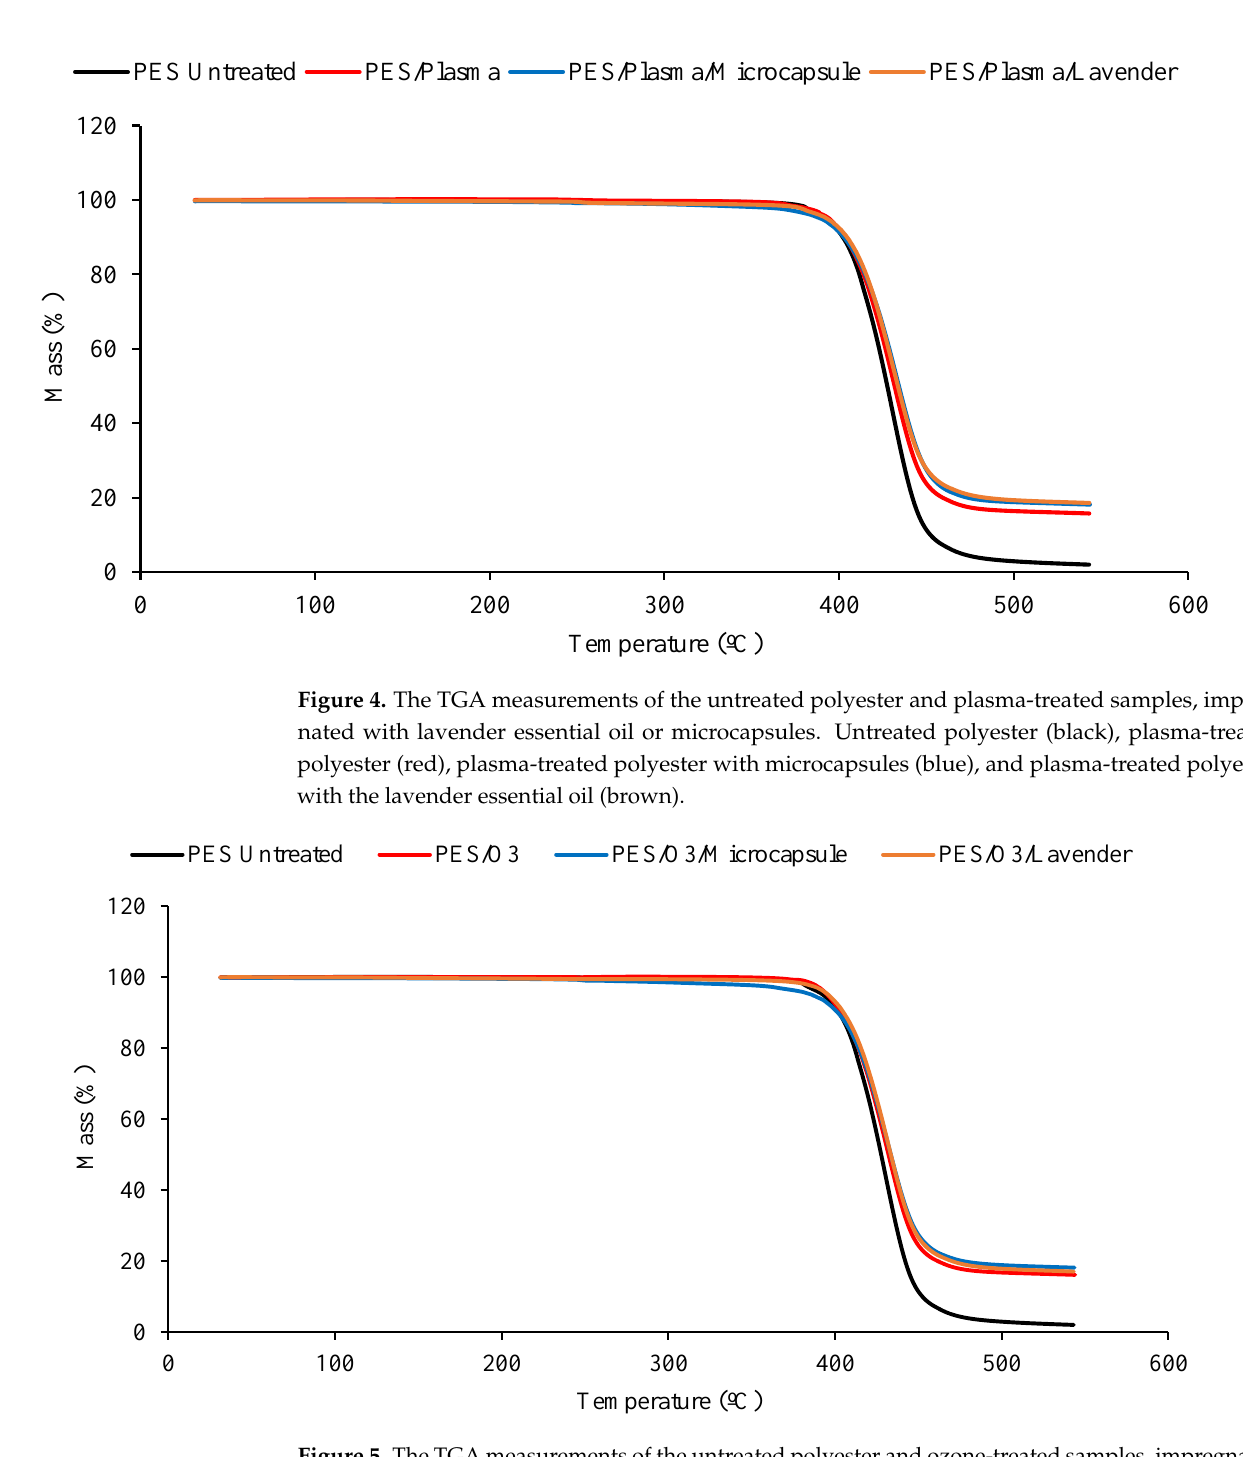
Figure 5. The TGA measurements of the untreated polyester and ozone-treated samples, impregnated with lavender essential oil or microcapsules. Untreated polyester (black), ozone-treated polyester (red), ozone-treated polyester with microcapsules (blue) and ozone-treated polyester with the lavender essential oil (brown).